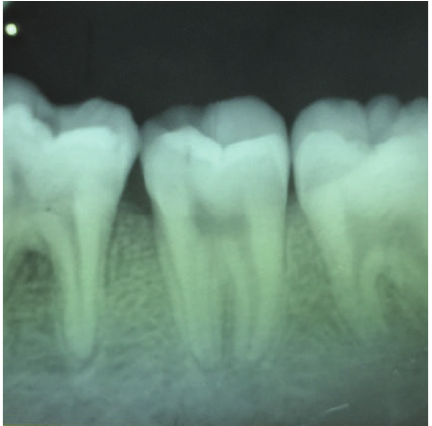
Figure 2: Preoperative photograph showing split tooth of 27.